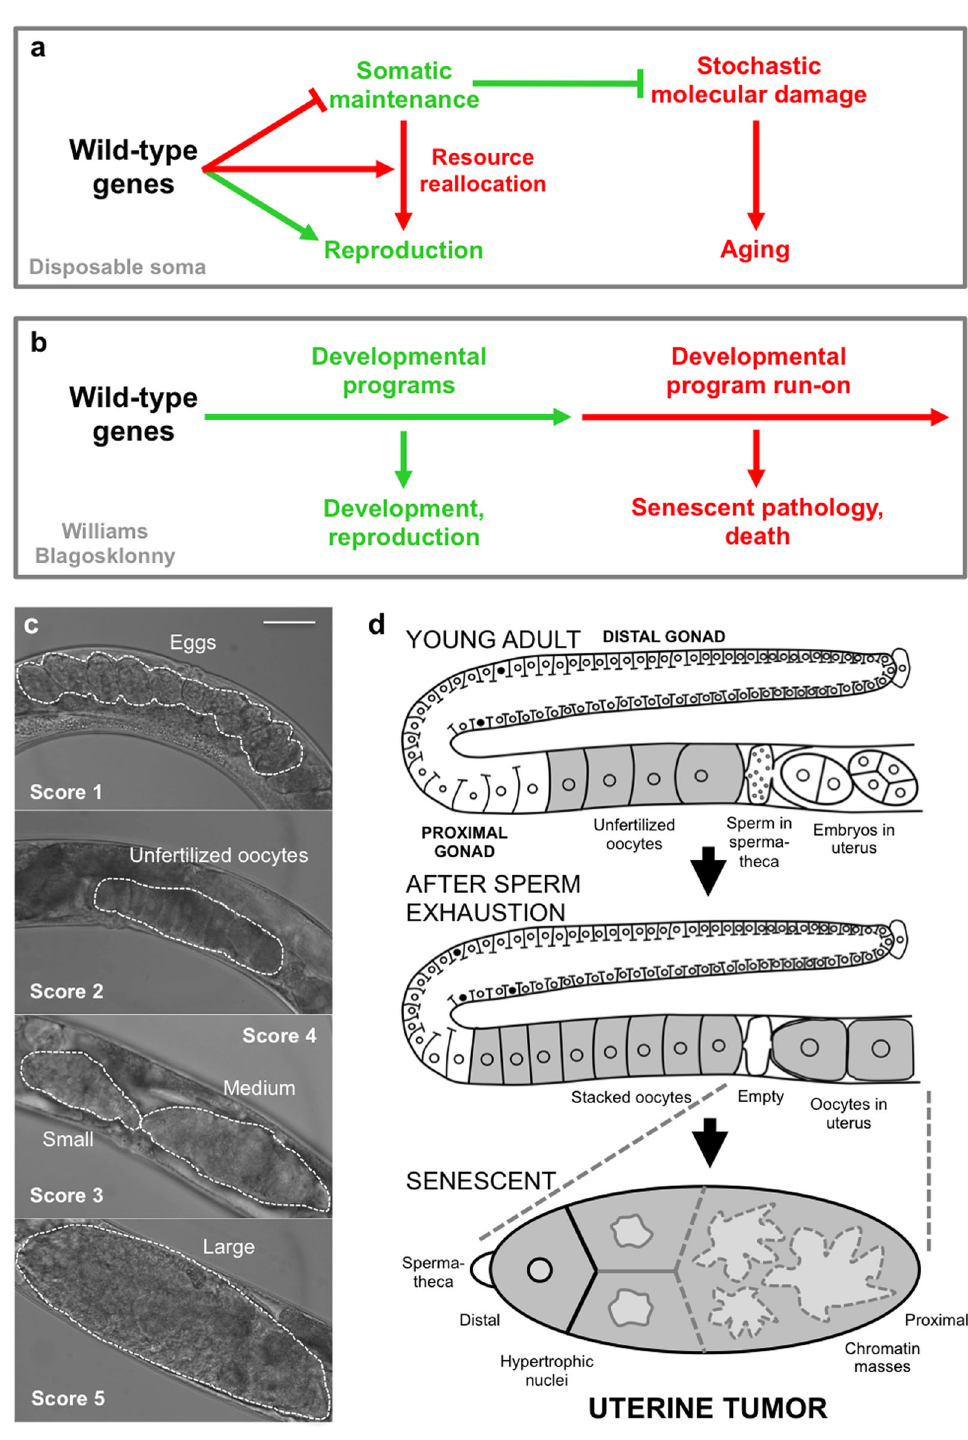
Fig. 1 Theories of aging and uterine tumor development. a , b Alternative models for how wild-type genes cause senescence (pathogenic action of alleles exhibiting antagonistic pleiotropy). a Disposable soma model. Wild-type genes promote reproduction at the expense of somatic maintenance processes that prevent the damage that causes aging. b Williams Blagosklonny model. Continued action of wild-type genes in later life leads to run-on of developmental programs (quasi-programs) causing development of senescent pathology. c , d Senescent uterine tumors in C. elegans hermaphrodites. c Stages of development of uterine tumors. Dotted lines delineate uterine contents. Scale bar, 50 μ m. d Schematic representation of uterine tumor development, consistent with Williams Blagosklonny model. As argued in this study, the point of origin of pathophysiology is immediately after fertilization with the last sperm in the spermatheca; this is the point of transition from program to quasi-program. Red, promoting senescent pathology